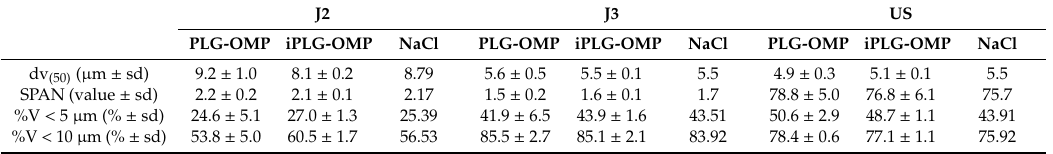
Table 3. Dimensional analysis of aerosols obtained by the nebulization of PLG-OMP, iPLG-OMP and saline solutions (NaCl 0.9% was used as a reference). Median diameter value (dv (50) ), distribution width (SPAN = (dv (90) − dv (10) ) / dv (50) ), percentage of particles that could reach the lower airways (%V < 5 µ m) and percentage of particles compatible with tracheobronchial distribution (%V < 10 µ m). Student’s t -test was applied to compare the data within each nebulization setting. J2